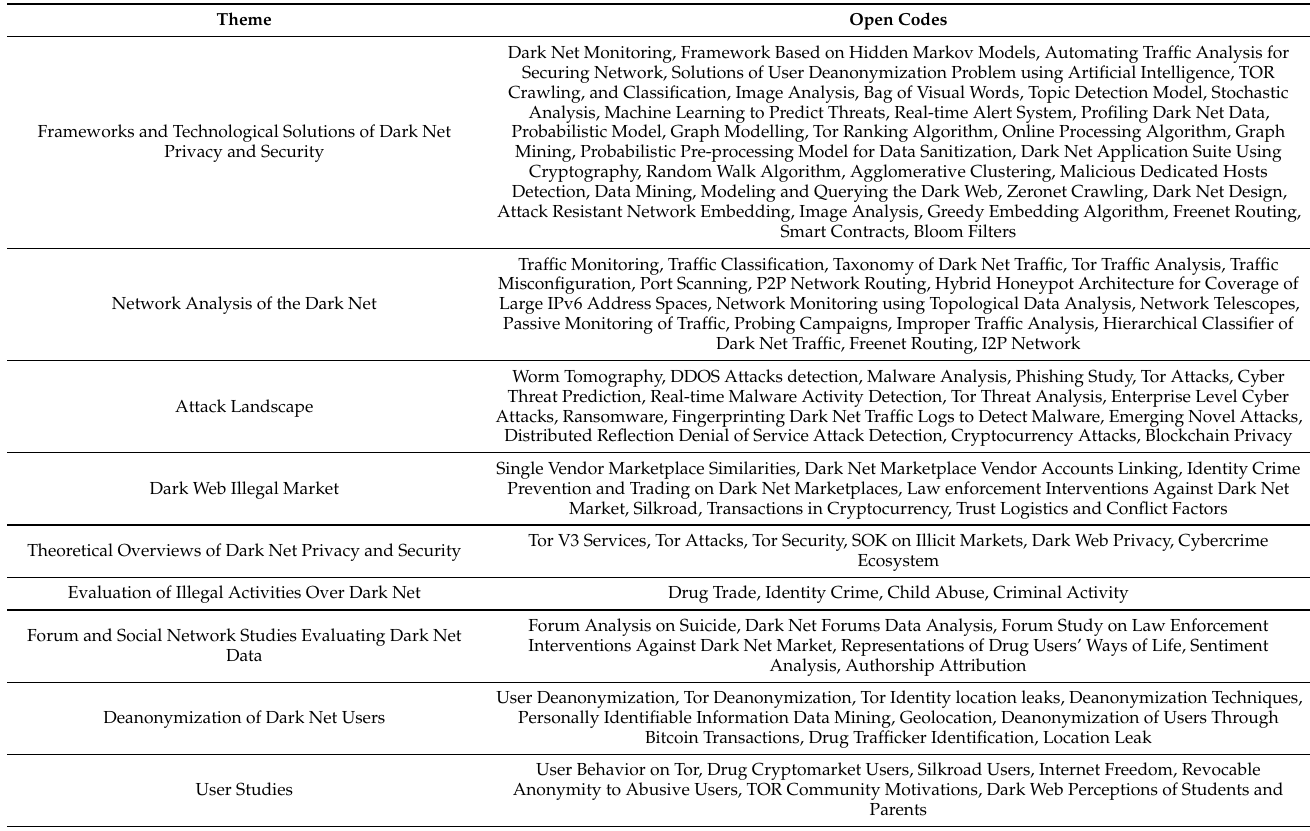
Table 1. A snapshot of the correlated open codes and themes generated for thematic analysis of the analyzed 200 papers on dark net user privacy and data